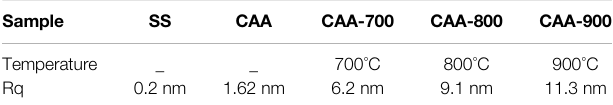
TABLE 3 | Surface roughness of the absorber treated at different temperatures in